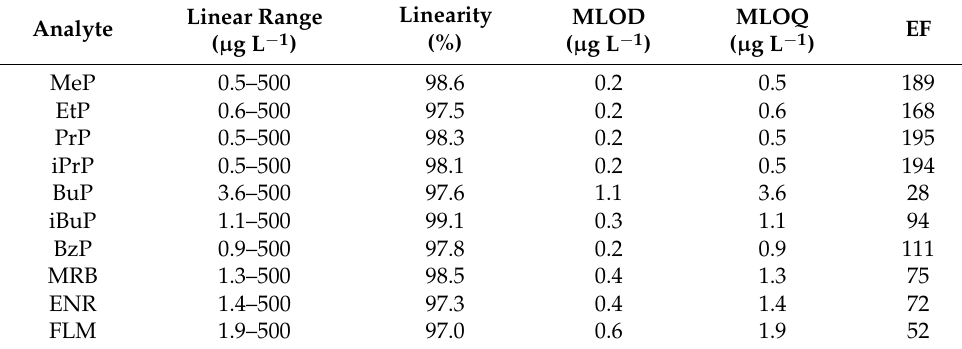
Table 2. Figures of merit (linearity, MLOD, MLOQ and EF) for target analytes.